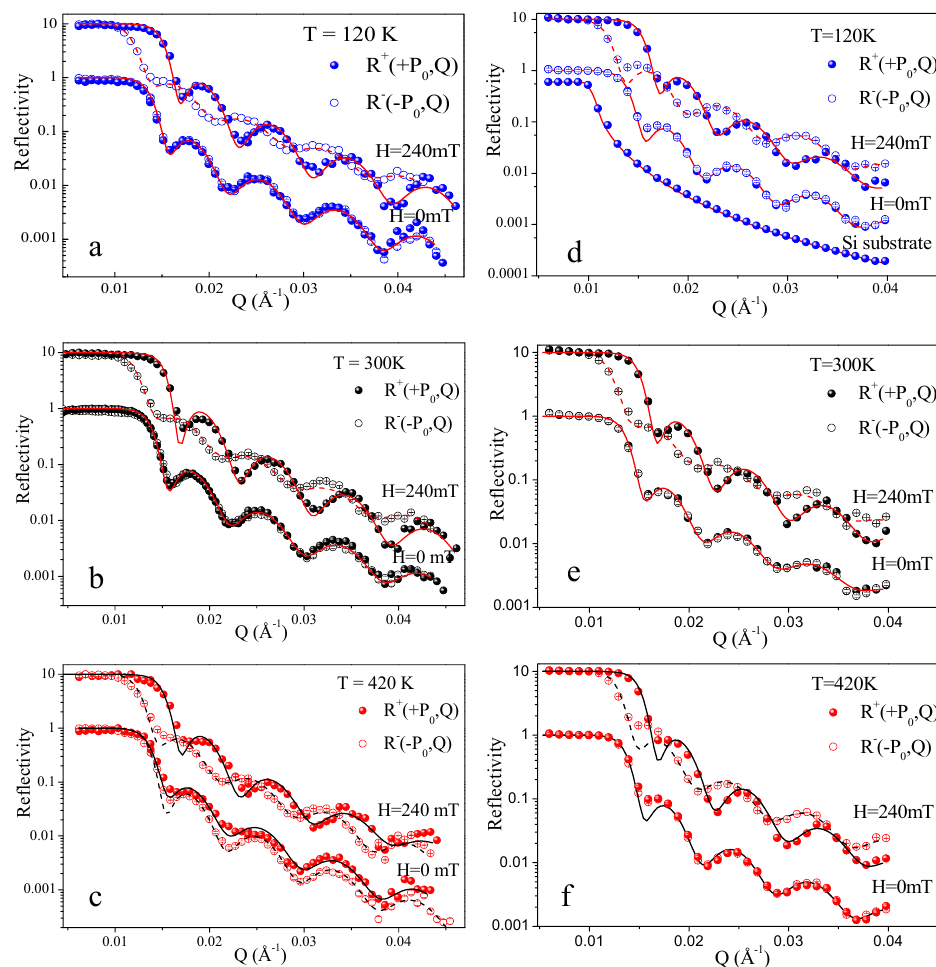
Figure 6. The experimental (symbols) and fitted model (lines) reflectivity curves for the samples Au/SiO 2 (60 at.% Co)/Si ( a – c ) and Au/SiO 2 (70 at.% Co)/Si ( d – f ) at fields B = 0 and B = 240 mT for T = 120 K ( a , d ), 300 K ( b , e ), and 420 K ( c , f ). Measured and fitted model curves at B = 240 mT are multiplied by 10 for